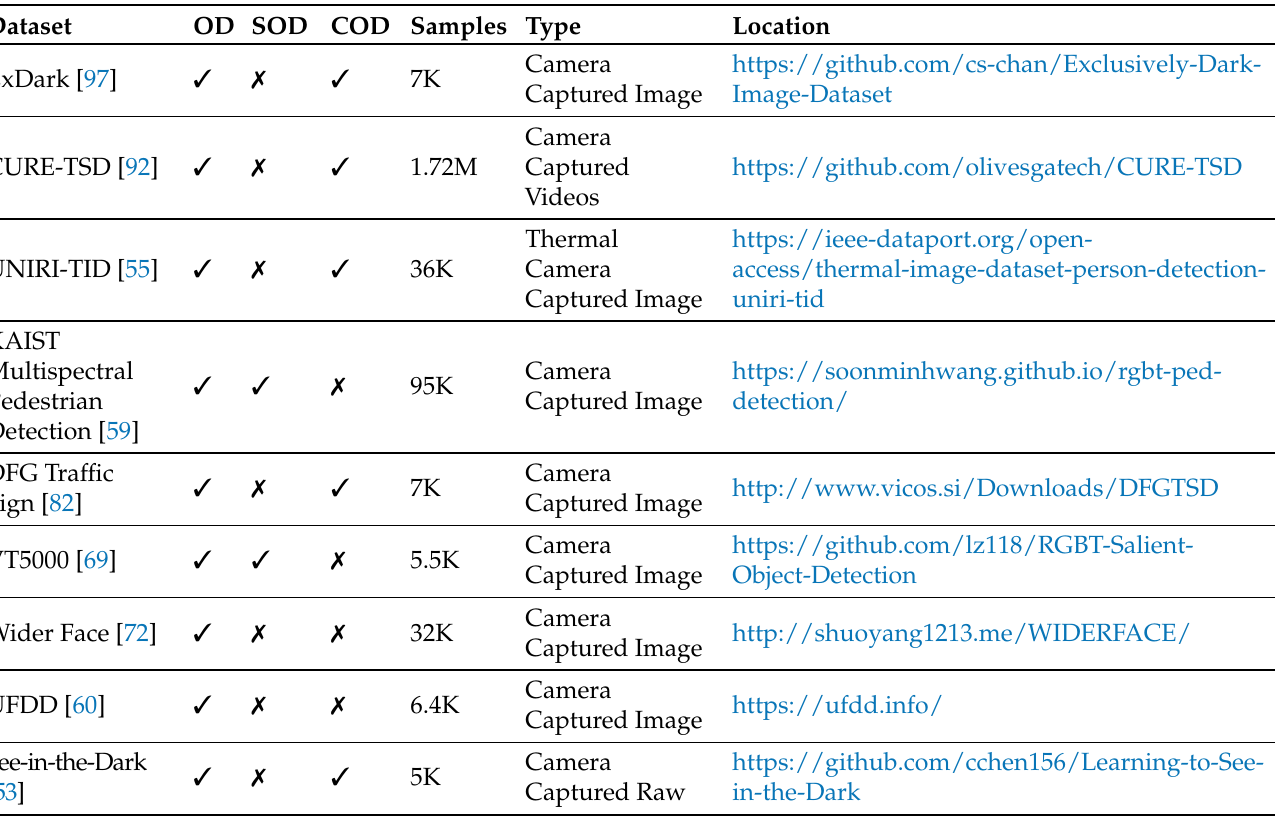
Table 2. Important statistics of challenging object detection datasets. OD denotes object detection, SOD represents salient object detection, and COD is for category specific object detection.